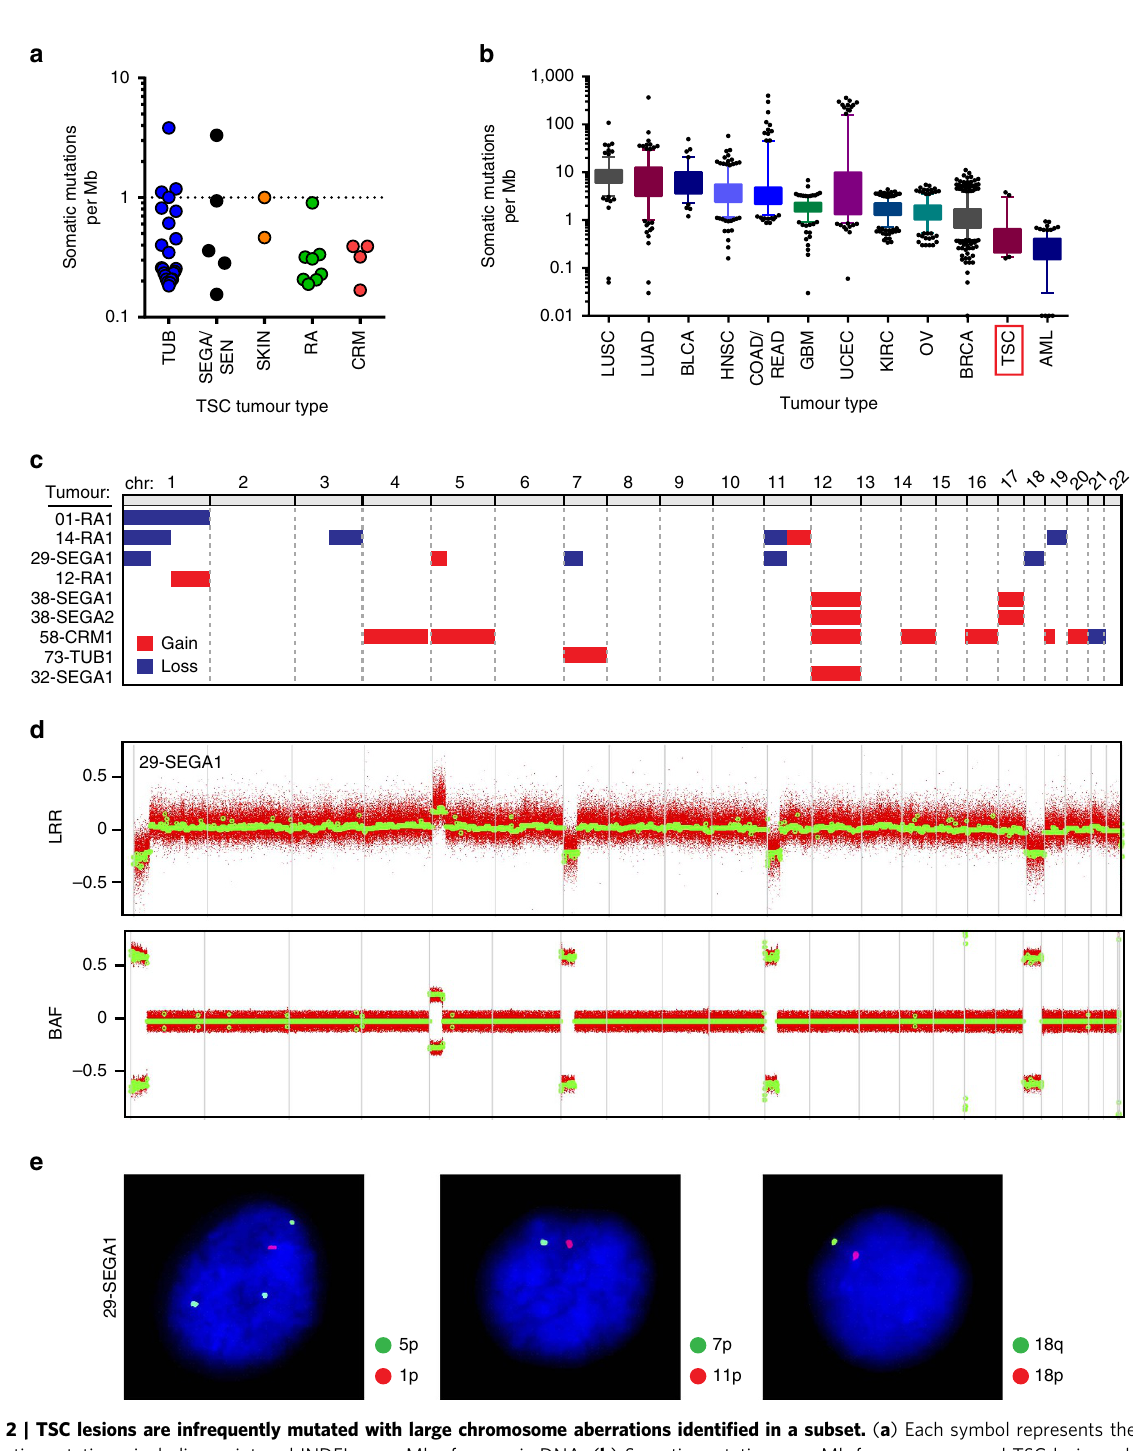
Figure 2 | TSC lesions are infrequently mutated with large chromosome aberrations identified in a subset. ( a ) Each symbol represents the number of somatic mutations, including point and INDELs, per Mb of genomic DNA. ( b ) Somatic mutations per Mb for cancerous and TSC lesions shown as boxes (25th to 75th percentile) and whiskers (5th to 95th percentile). Outliers shown as individual data points. ( c ) GISTIC was used to call whole and arm-level CNAs using processed SNP array data. Gains (3 n ) are shown in red and losses (1 n ) are shown in blue. ( d ) All CNAs were visually confirmed with genome-wide LRR and BAF plots. 29-SEGA1 is shown as an example. ( e ) FISH was used to confirm large CNAs. Representative nuclei, stained with DAPI in blue, show single fluorescent puncta using probes to chromosome 1p, 11p, 7p, 18p and 18q, and three fluorescent puncta using a probe to chromosome 5p, confirming losses and gains, respectively. AML, acute myeloid leukemia; BLCA, bladder urothelial carcinoma; BRCA, breast invasive carcinoma; COAD, colon adenocarcinoma; GBM, glioblastoma multiforme; HNSC, head and neck squamous cell carcinoma; KIRC, kidney renal clear cell carcinoma; LUAD, lung adenocarcinoma; LUSC, lung squamous cell carcinoma; OV, ovarian serous cystadenocarcinoma; READ, rectum adenocarcinoma; TSC, tuberous sclerosis complex; UCEC, uterine corpus endometrial